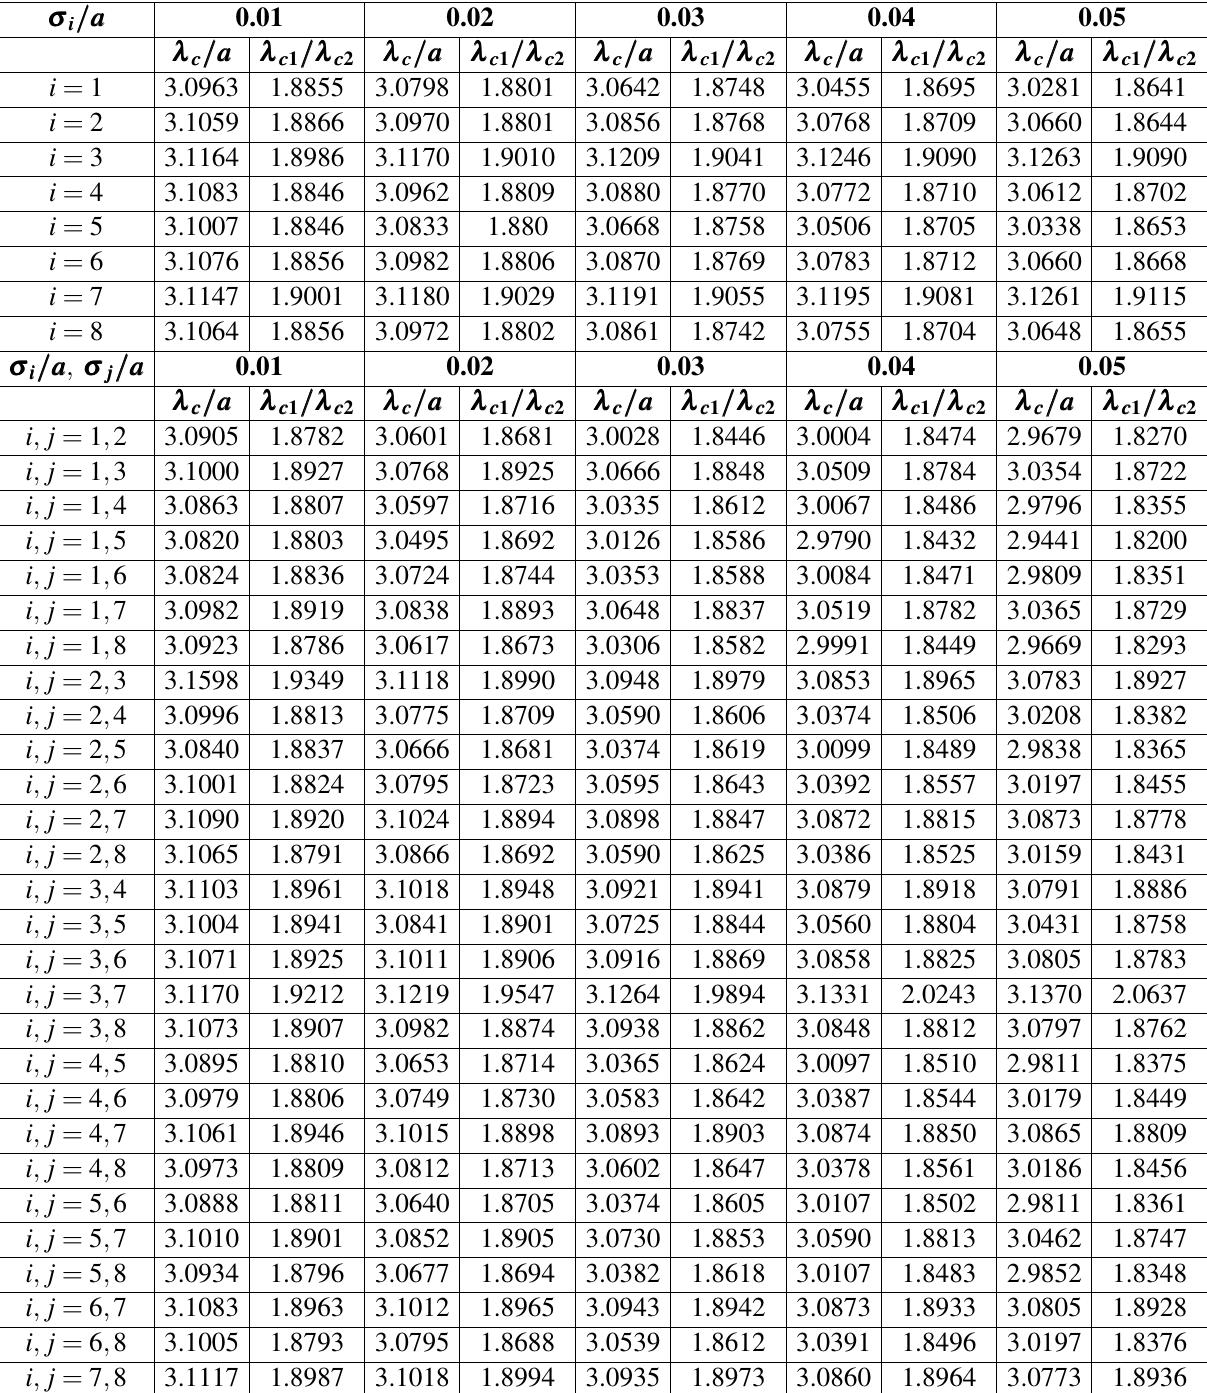
Table 5 The changes of of λ c / a and λ c 1 / λ c 2 in deformed bilateral